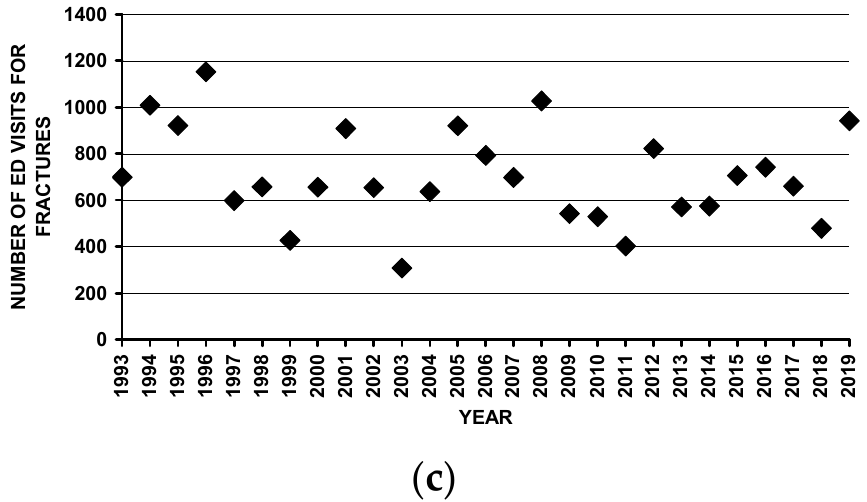
Figure 7. Temporal variability in the number of ED visits for fractures in children < 16 years old: ( a ) by day of the week. Note the increased number of ED visits on the weekend); ( b ) by month. Note that there is no apparent pa tt ern. There was no change by month upon linear regression analysis: r 2 = 0.057, p = 0.45. Additionally, cosinor analysis [37,38] demonstrated no rhythmic pa tt ern as seen in